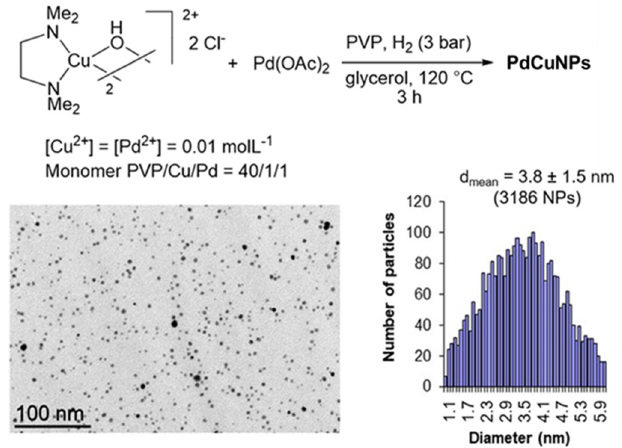
Figure 13. Synthesis of PdCu–BMNPs in neat glycerol by co-reduction of equimolar metal precursors, TEM micrograph and corresponding size distribution diagram of PdCu-BMNPs [247]. Reproduced from [247] with permission from the American Chemical Society.